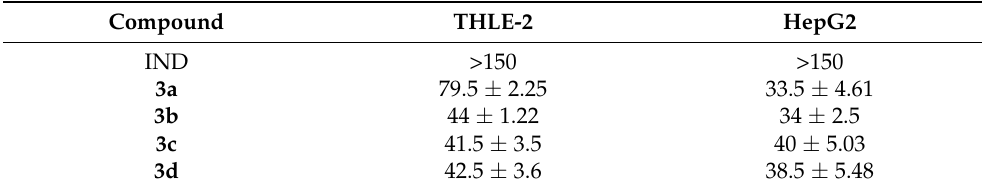
Figure 1. The effect of IND and OAO–IND derivatives ( 3a – d ) on the viability of HepG2 ( panel A ) and THLE-2 ( panel B ) cells. Data (means ± SEM) from three separate experiments are presented. Table 1. Comparison of OAO–IND derivatives’ cytotoxicity in non-tumorigenic (THLE-2) and hepatoma cells (HepG2)*.